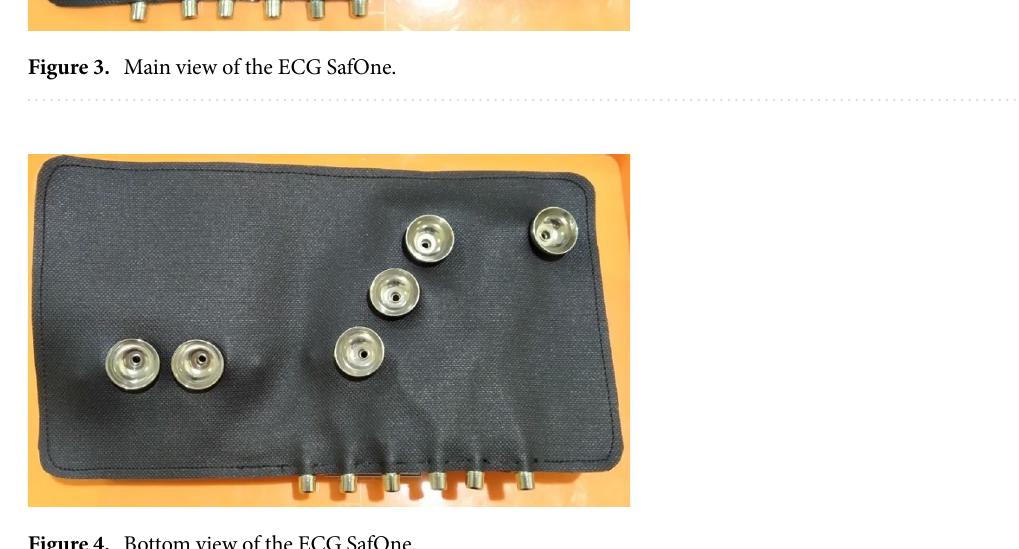
Figure 4. Bottom view of the ECG